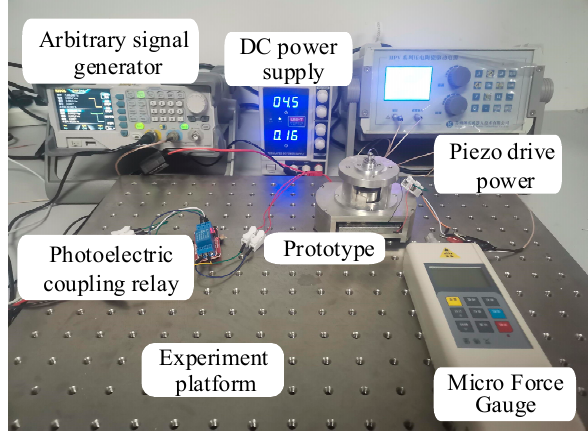
Figure 16. Flow chart of the output characteristic test system.